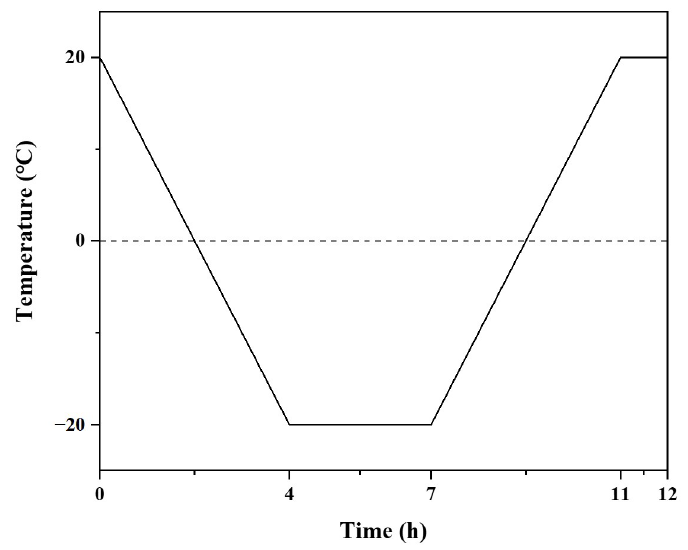
Figure 3. Freeze-thaw cycle system.